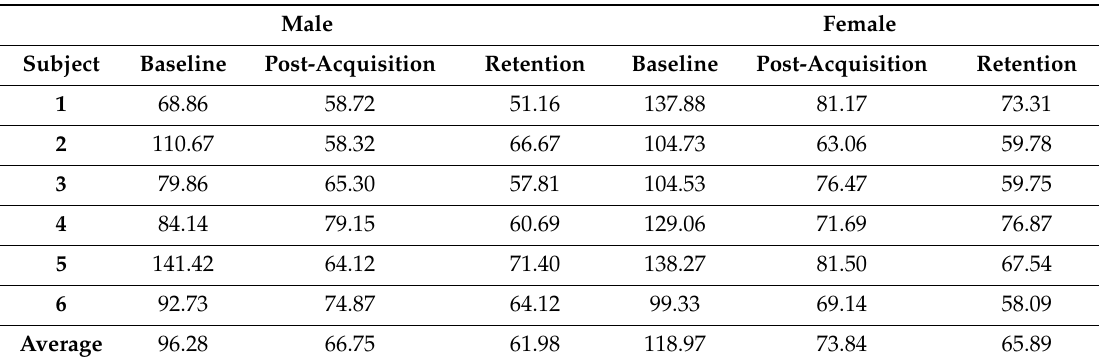
Table 1. Male and female task accuracy measured as percentage of error. One dot width from the target trace was considered 100% error. Male